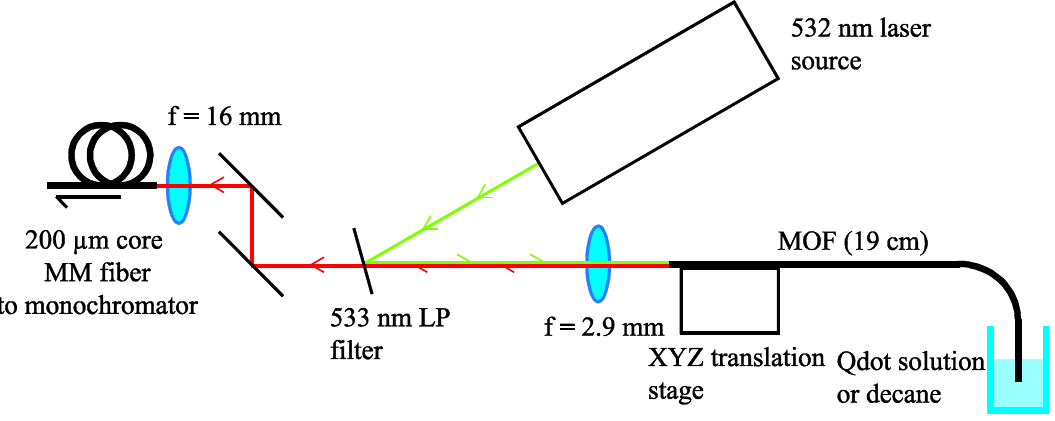
Figure 3. Experimental configuration for fiber-based fluorescence measurements.